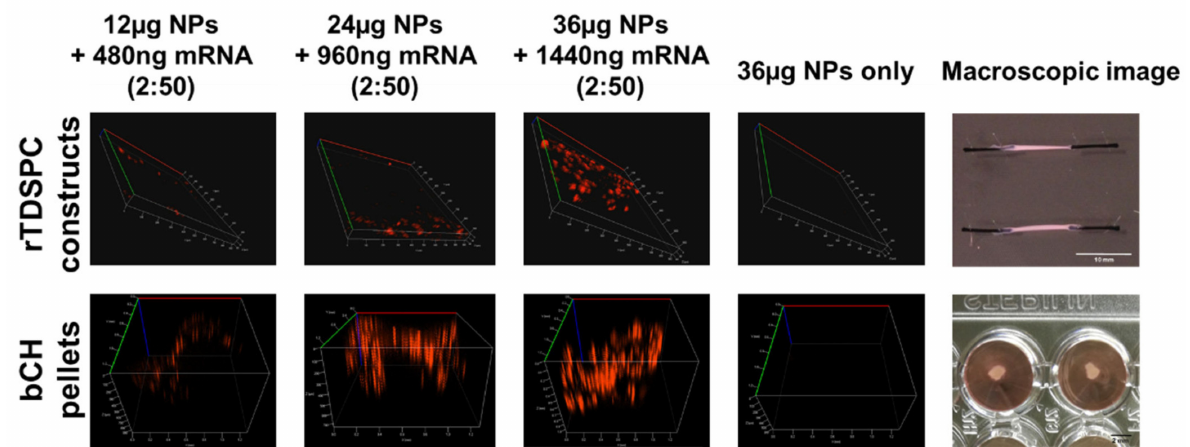
Figure 7. Transfection of 3D constructs of bCH and rTDSPC with the optimal mRNA:nanoparticle ratio of 2:50 ( w / w ). Representative Z-stacks of unfixed pellets and 3D tendon-like constructs demonstrating ability of the mRNA-loaded NPs to transfect cells embedded in a dense, collagenous